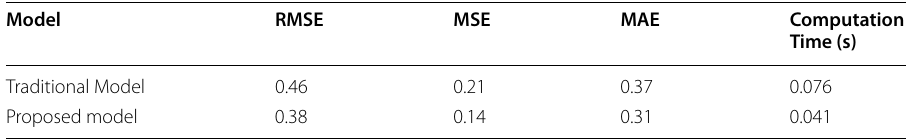
Table 4 Performance evaluation model Model RMSE MSE MAE Computation Traditional Model